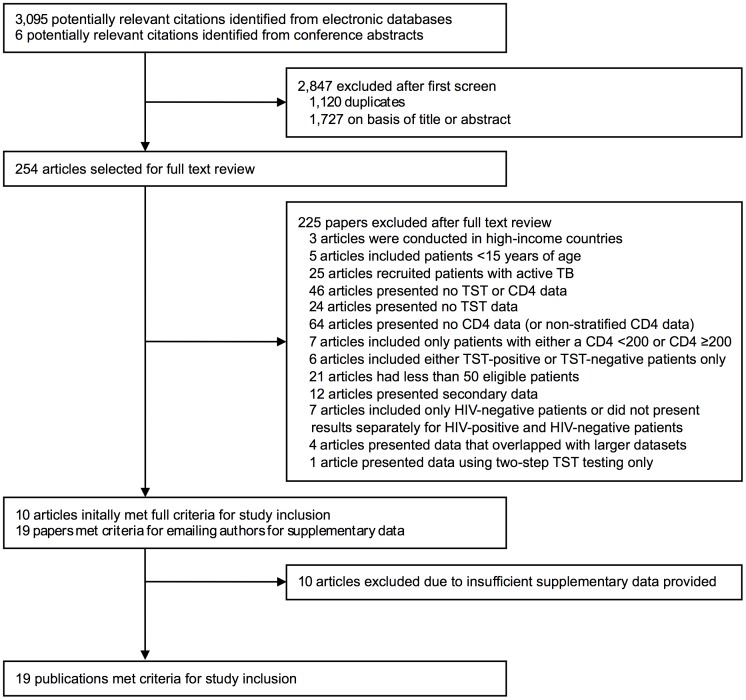
Selection of eligible studies containing data on the proportion of people living with HIV testing tuberculin skin test (TST)-positive stratified by blood CD4 cell count.